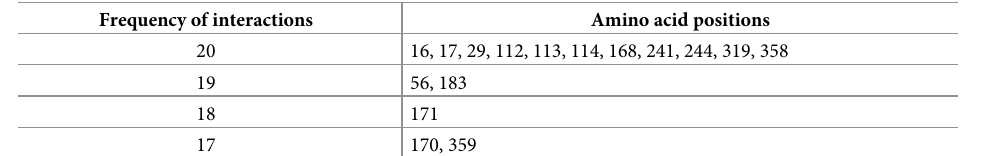
Table 1. Interaction of substrate with